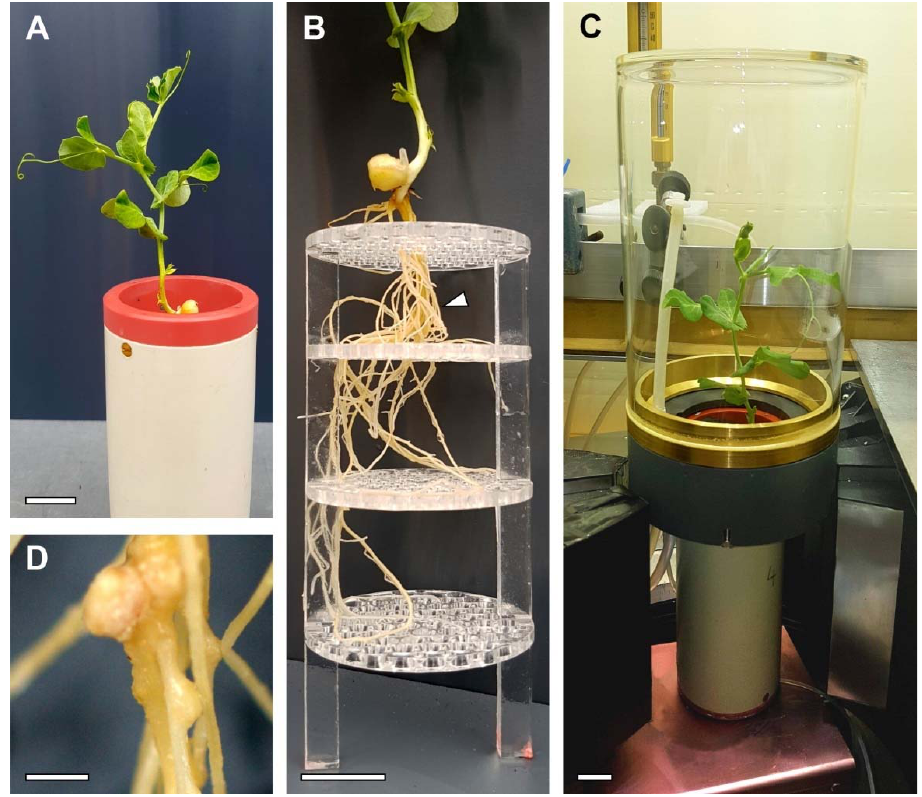
Figure 2. Plant cultivation and labelling set ‐ up. ( A ) Sixteen ‐ days ‐ old Garden pea ( Pisum sativum L. cv. Kayanne) in PVC pots with nutrient solution. ( B ) Transparent stabilizing support grid for reducing root displacement during plant transfer between PET and MRI measurements. Arrow indicates region shown enlarged in panel ( D ). ( C ) Overview image of a pea plant with 11 CO 2 tracer labelling cuvette situated above the PET detectors positioned at the level of the pot. ( D ) Representative nodules in the root system of a pea plant. Scale bars, ( A – C ) 20 mm, ( D ) 2 mm.